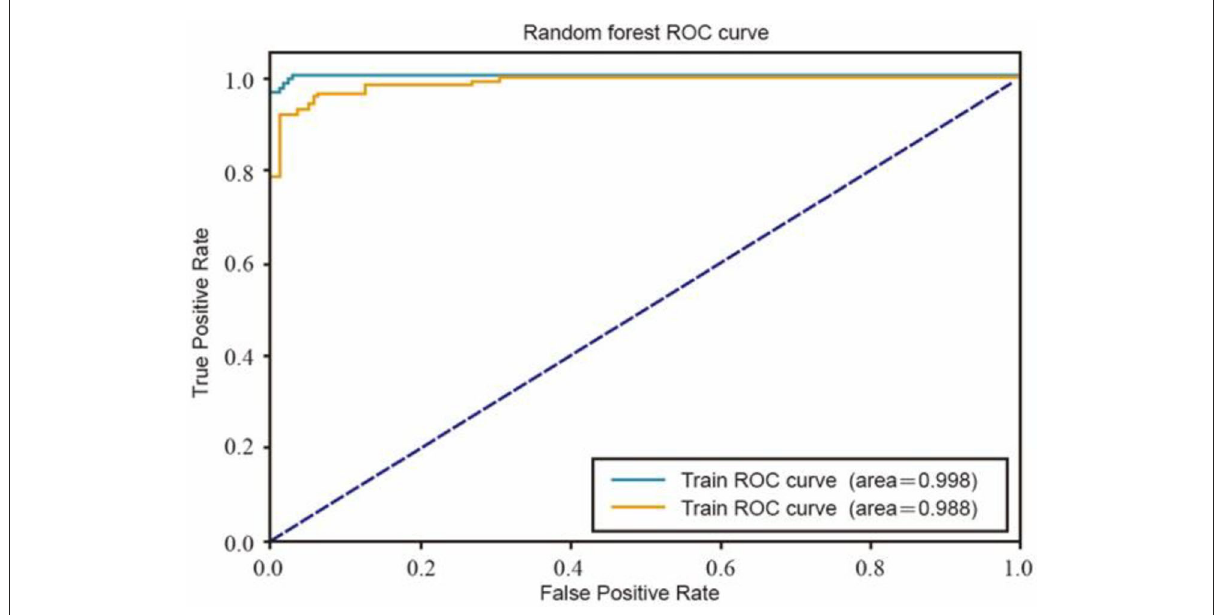
FIGURE3 Random forest ROC curve.